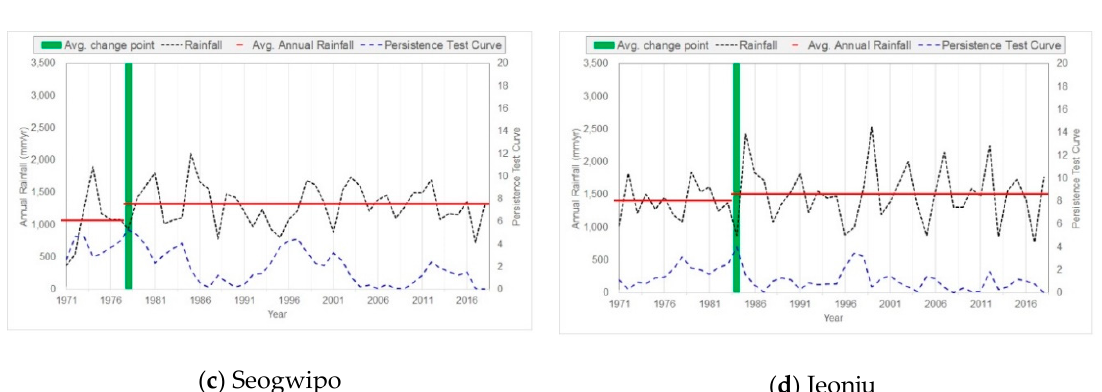
Figure 9. Serial correlation coefficient graphs showing no persistence. ( a ), ( b ), ( c ), and ( d ) each represent graphs of Jeongeup, Daejeon, Seogwipo, and Jeonju.